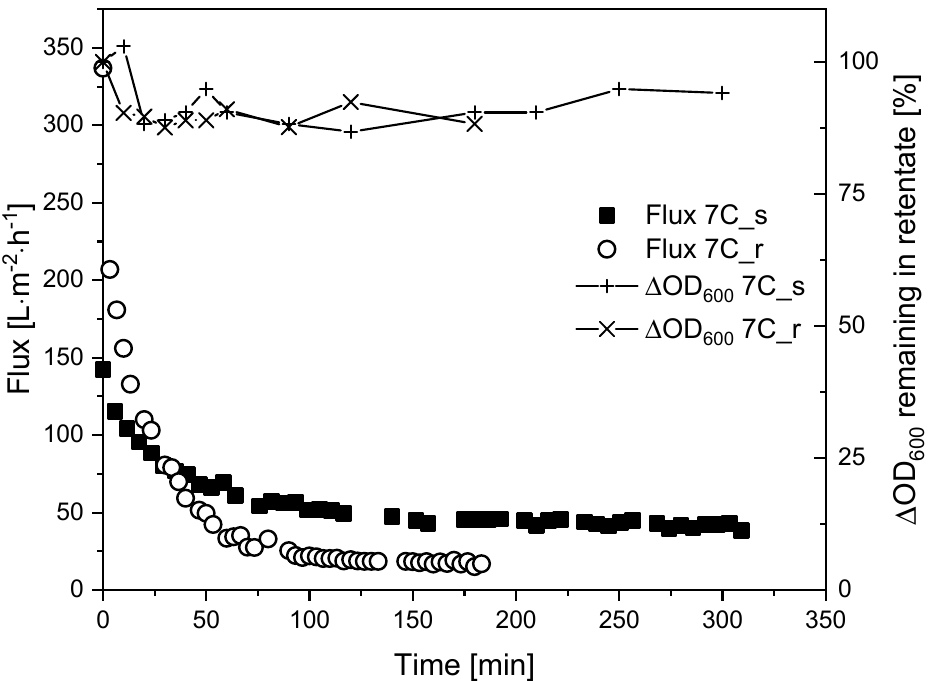
Figure 8. Flux curves and biomass remaining in the retentate during the filtration of K. lactis cells (TMP = 0.5 bar, CFV = 1.1 m s -1 , temperature = 25 °C) using membranes 7C_s and 7C_r.